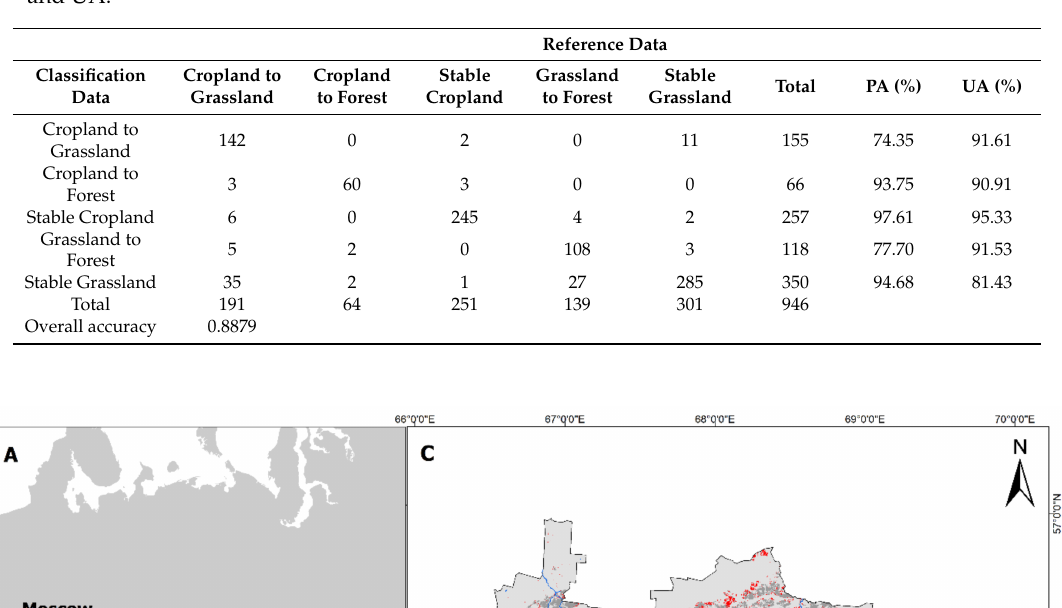
Table 3. Confusion matrix for the land-use land-cover (LULC) change map with overall accuracy, PA, and UA.